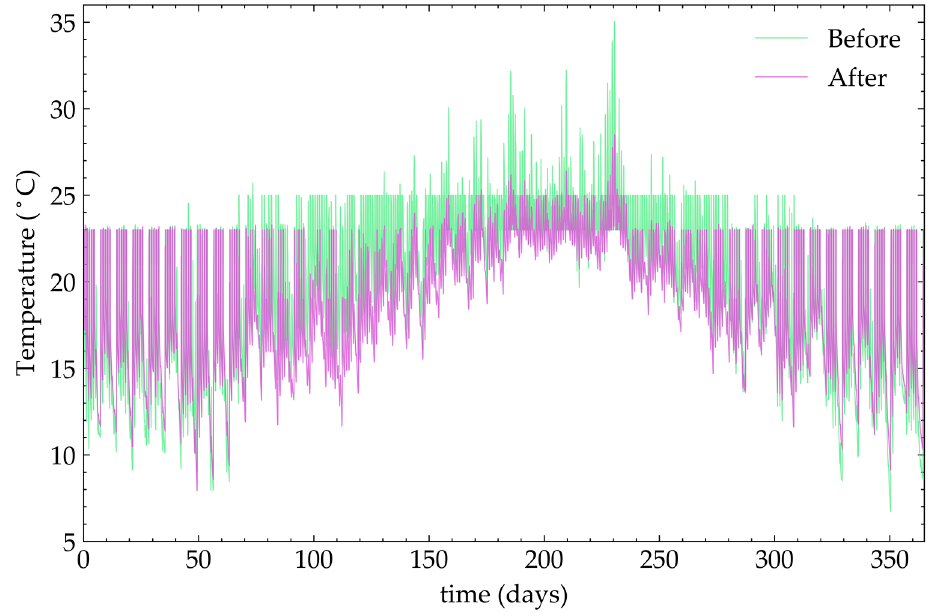
Figure 6. The Welsh pilot room temperature (in °C) before/after the